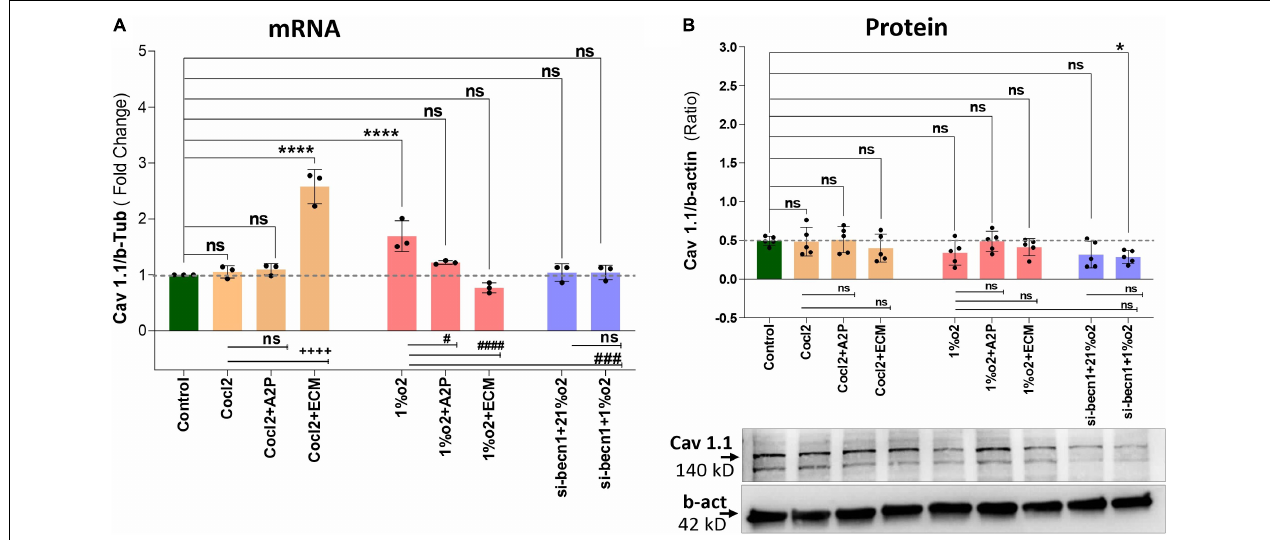
FIGURE 2 | Hypoxia and Cocl2 exposure not significantly altered the H9c2 cells Cav1.1 (CACNA1S) mRNA and protein expression levels. (A) Cav1.1 mRNA expression levels, (B) Cav1.1 Protein expression levels, and representative western blots. Cav1.1 mRNA levels was increased in h9c2 cells exposed to Cocl2 + ECM (**** p < 0.0001), and not changed significantly in Control vs. Cocl2, Cocl2 + A2P, 1%O2 + A2P, 1%O2 + ECM, and in Beclin-1 inhibition cells grown under normoxia and hypoxia conditions. Compared to Hypoxia (1%O2), cells exposed to 1%O2 + A2P ( # p < 0.010), 1% O2 + ECM, ( #### p < 0.0001), and in Beclin-1 inhibition ( ### p < 0.0005) cells grown under Hypoxia expressed significant decrease in Cav1.1 mRNA levels. However, Cav 1.1 protein expression levels only decreased in (* p < 0.047) Beclin-1 inhibition cells under hypoxia and not significantly changed in all other experimental groups. Data represents, n = 3 (mRNA) and n = 5 (Protein) independent samples/group. Bars are mean ± S.D. Symbols * , + , # , and (cid:54)= denotes significant, “ns” represents not significant by two-way ANOVA- multiple comparisons test. P-values are ns p > 0.05, * p < 0.05, ** p < 0.01, *** p < 0.001, and **** p < 0.0001 compared to Control; + p < 0.05, ++ p < 0.01, +++ p < 0.001, and ++++ p < 0.0001 compared to Cocl2; # p < 0.05, ## p < 0.01, ### p < 0.001, and #### p < 0.0001 compared to Hypoxia; (cid:54)= p < 0.05, (cid:54)= (cid:54)= p < 0.01, (cid:54)= (cid:54)= (cid:54)= p < 0.001, and (cid:54)= (cid:54)= (cid:54)= (cid:54)= p < 0.0001 compared to si-becn1 (21%O2) Vs, si-becn1 (1%O2). In western blots “ → ” represents a specific